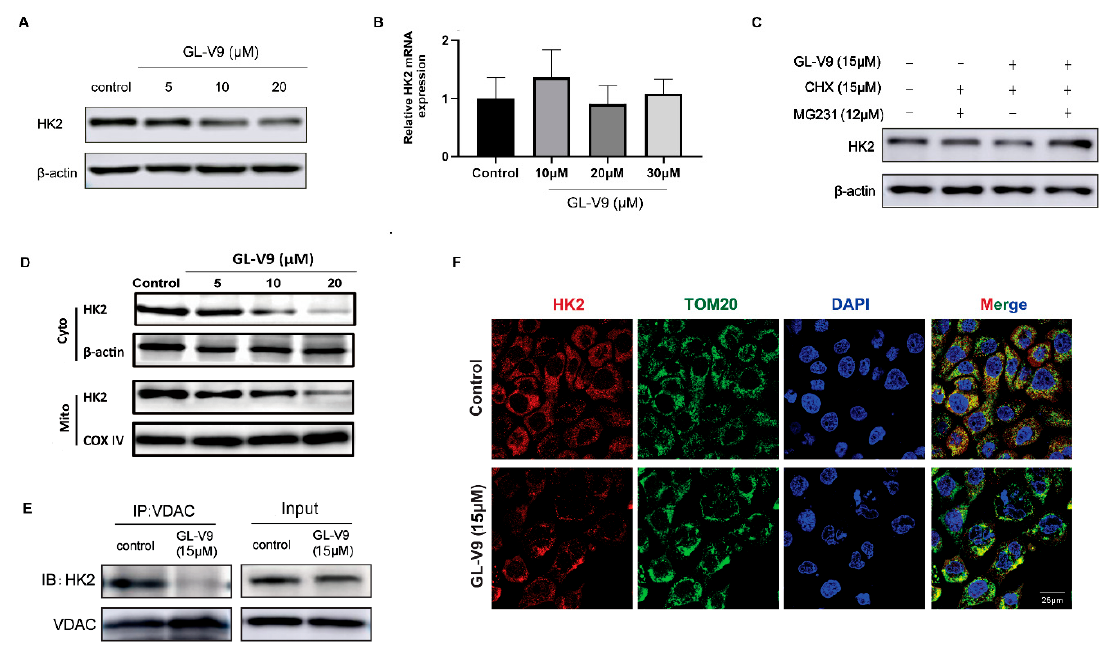
Figure 5. GL-V9 downregulates protein stability of HK2 and inhibits its mitochondrial location. ( A , B ) A431 cells were treated with GL-V9 for 36 h. The protein expression ( A ) and mRNA expression ( B ) of HK2 were assayed by western blot and RT-PCR, respectively. Bars, SD from three independent experiments. ( C ) A431 were treated with 15 µ M GL-V9 for 24 h, then co-treated with 15 µ g / mL CHX and 12 µ M MG-132 for another 12 h. Then protein level of HK2 was assayed. ( D ) The expression of HK2 proteins in cytosol and mitochondria was examined by western blot. ( E ) The binding of HK2 with VDAC was assayed by immunoprecipitation. ( F ) The location of HK2 in mitochondria was observed by immunofluorescence. TOM20 was a mitochondrial marker. Scale bar = 25 µ m .